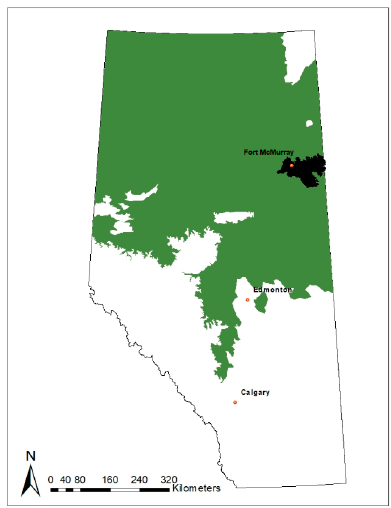
Figure 1. Map of field study area. Green area is the boreal forest within Alberta, Canada, while the black area is the Horse River fire, which burned an area of 589,617 ha in 2016.